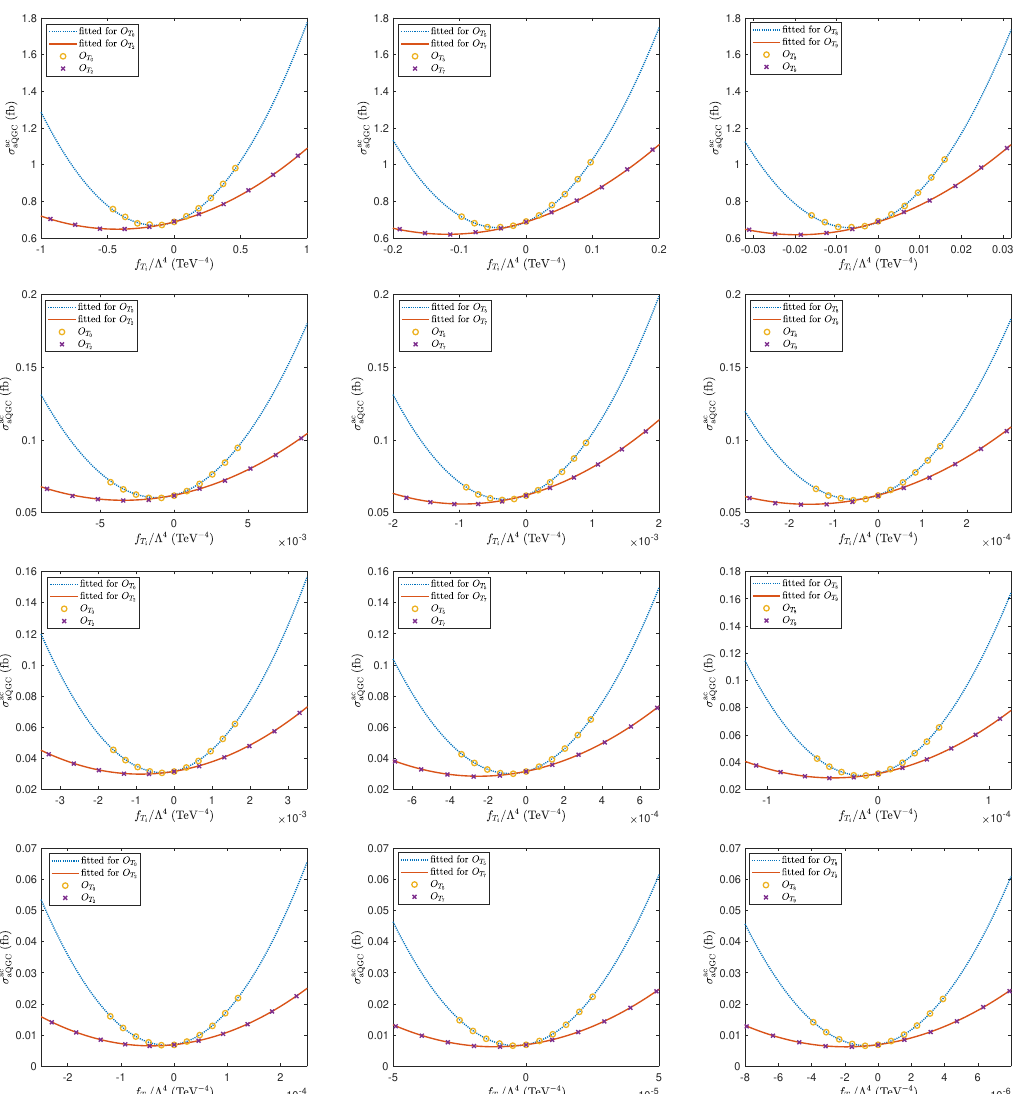
√ / Λ 4 at s = 3 TeV (row 1), 10 TeV i